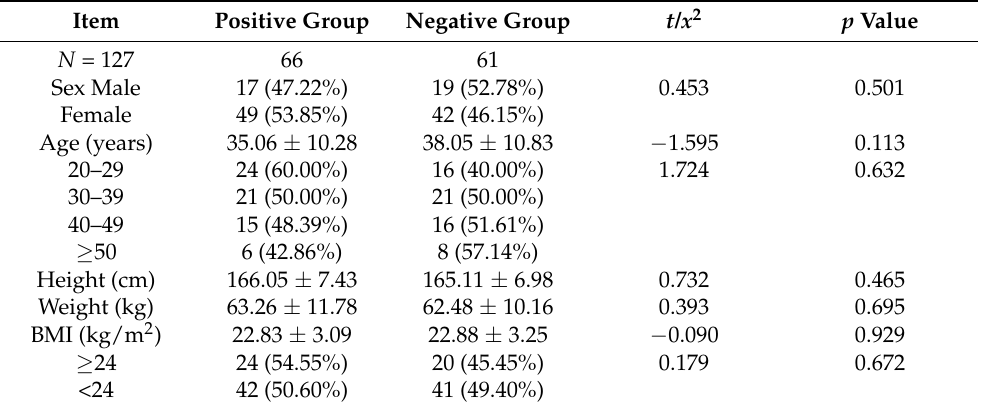
Table 2. The results of SARS-CoV-2 neutralization antibodies in 127 cases classified by demographic characteristics.